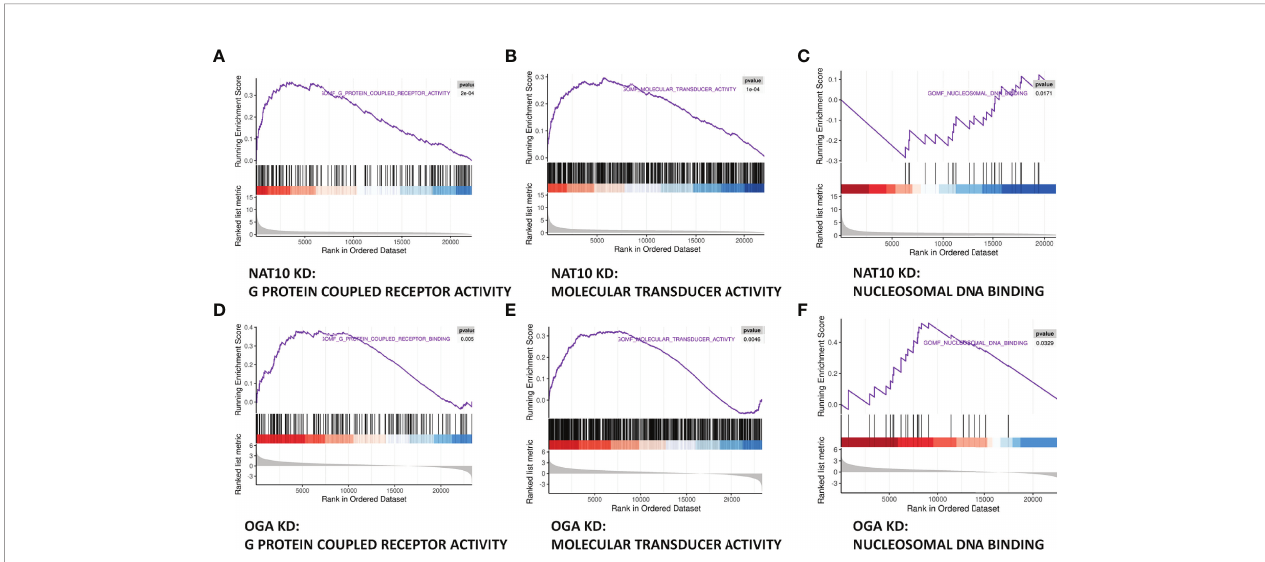
FIGURE 6 | Joint Analysis of NAT10-depleted and OGA-depleted Transcriptomes. (A – C) GSEA analysis showed that NAT10 KD transcriptome genes were mainly enriched in G protein – coupled receptor activity, molecular transducer activity, and nucleosomal DNA binding. (D – F) OGA-depleted expression pro fi ling was enriched in similar gene sets as NAT10-KD according to GSEA analysis.